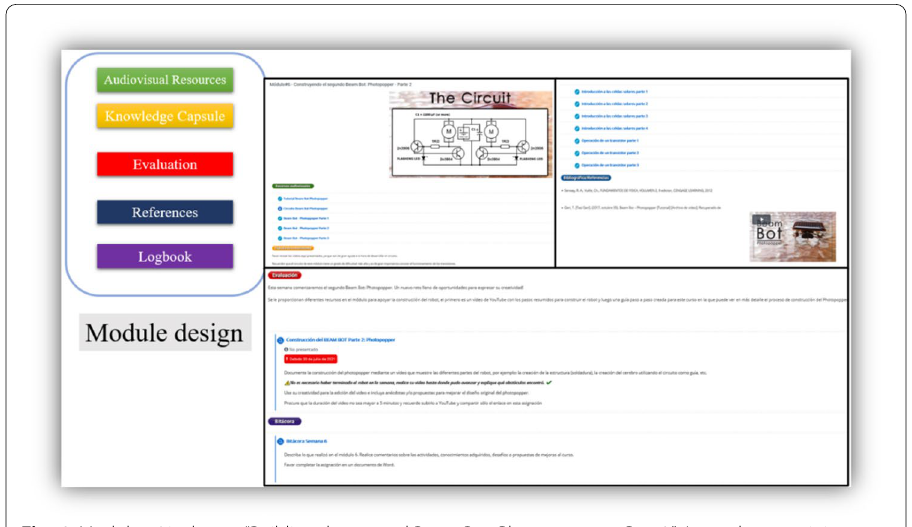
Fig. 6 Module #6 is shown: “Building the second Beam Bot: Photopopper—Part 2”. As can be seen, it is organized by five tags: Audiovisual Resources, Knowledge Capsule, Evaluation, References, and Log. Students have access to video tutorials, evaluation activities, and the possibility of relating their experiences in a